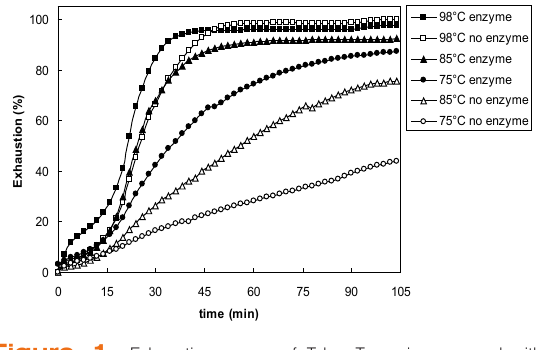
Figure 1. Exhaustion curves of Telon Turquoise on wool with or without enzyme pretreatment.